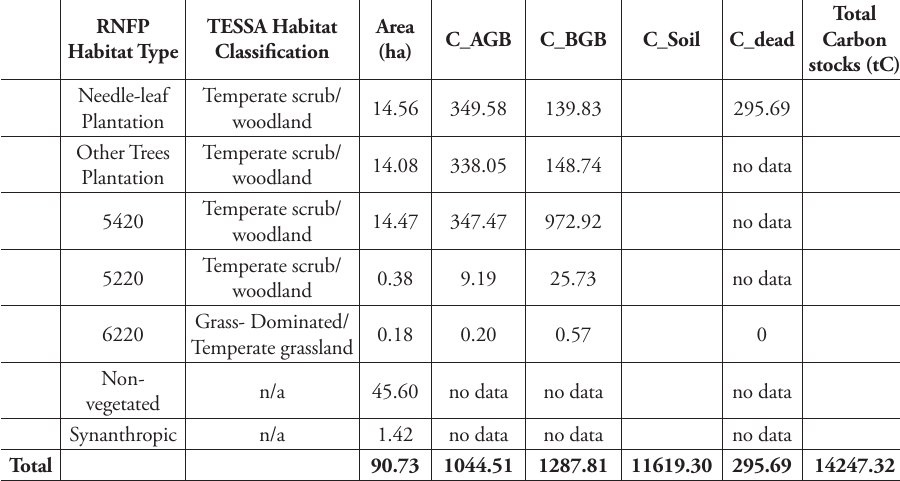
Table 5. Summary of total carbon estimation results per habitat type.